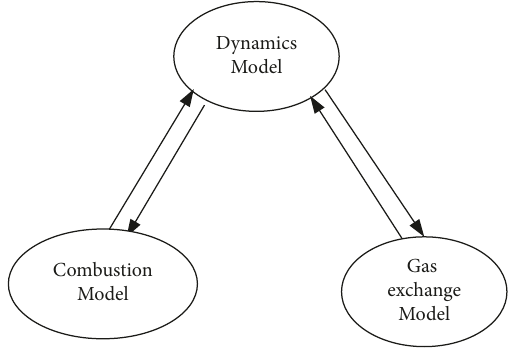
Figure 2: The iterative calculation schematic